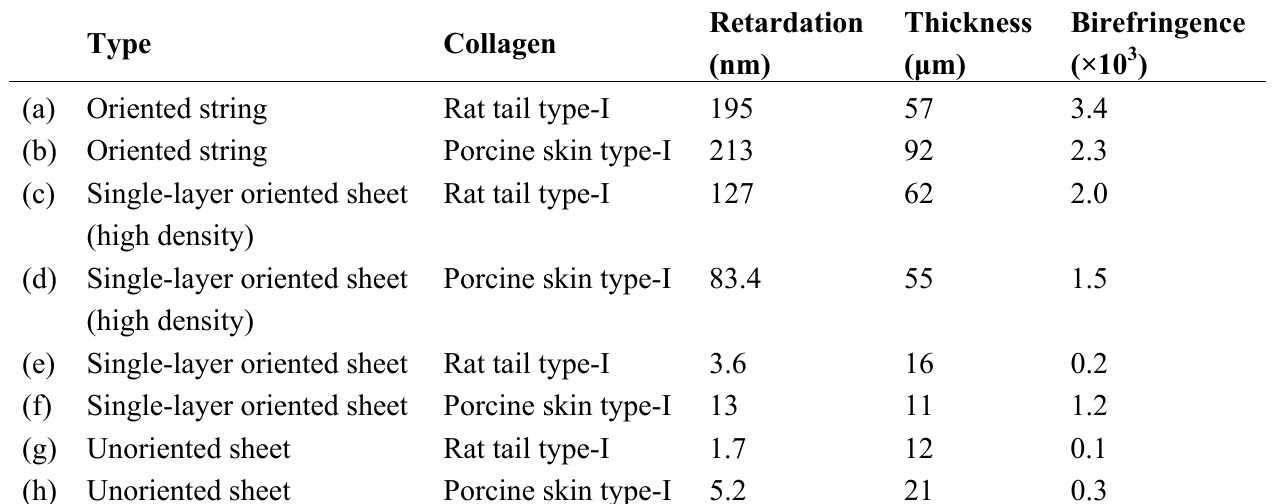
Table 1. Birefringence of dehydrated oriented collagen